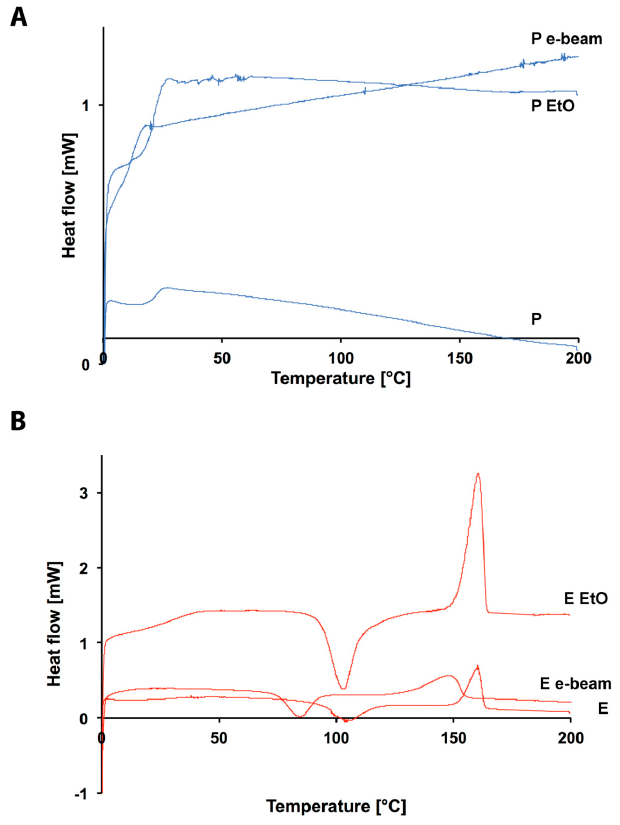
Figure 3. DSC curves of: ( A ) P, P EtO and P e-beam (blue lines); ( B ) E, E EtO and E e-beam (red lines).